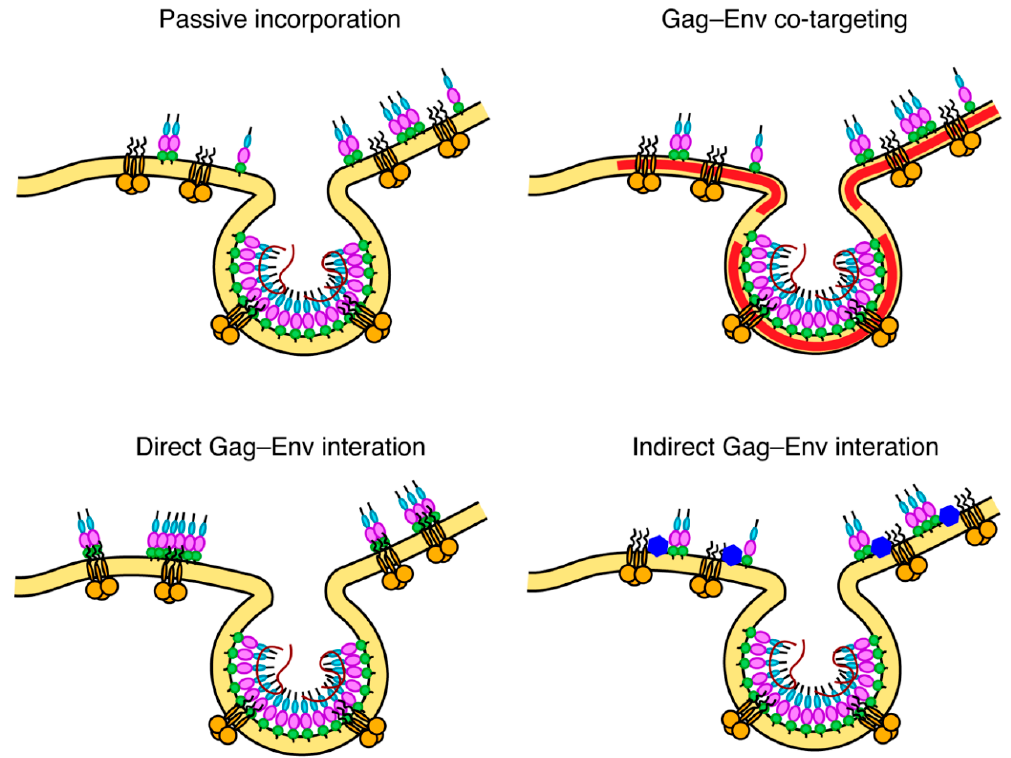
Figure 5. Possible models for Env incorporation. The passive model assumes that Env is randomly incorporated as particles may acquire a host-derived membrane during assembly and budding. The Gag–Env co-targeting model suggests that both proteins are recruited to assembly sites based on their independent association with an element of the PM such as lipid raft-like microdomains. The direct Gag–Env interaction model postulates that an interaction occurs between the MA domain of the Gag lattice and gp41CT. The indirect interaction model suggests that interaction is mediated by a cellular factor. These models were first proposed by Tedbury et al. [111]